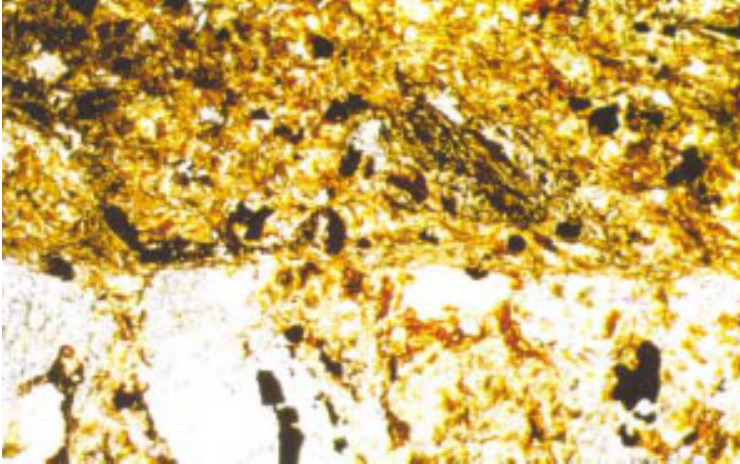
Figura 6. Fotomicrografia do espelho de falha no horizonte C de um Latossolo Vermelho-Escuro.